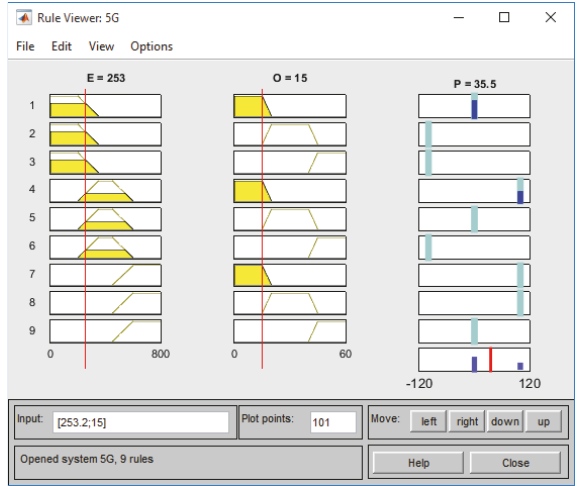
Figure 8: Simulation results. Probability for call acceptation is 35.5%. It means the call is likely to be passed to the system.